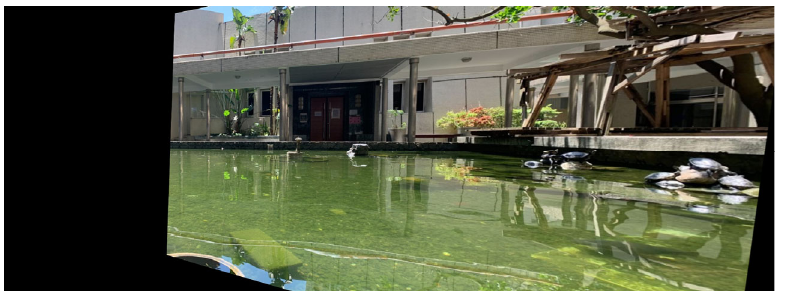
Figure 17. Homograph corresponding to the two photos, Figure 14b is rotated and deformed based on Figure 14a.